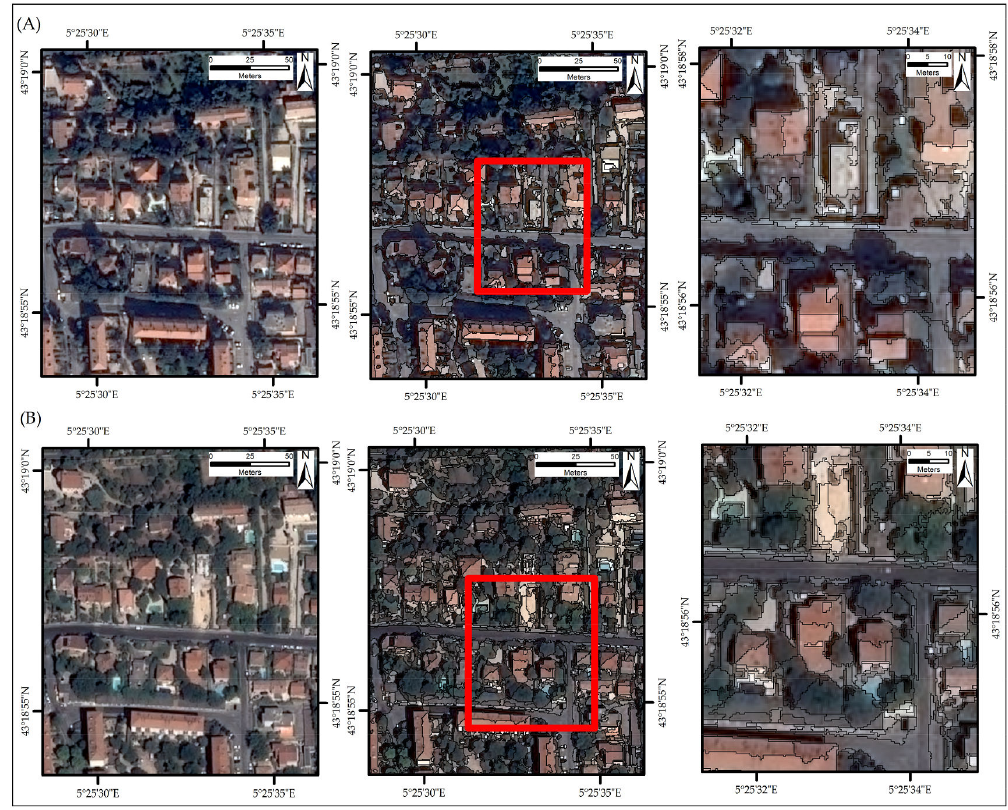
Figure 5. Segmentation results over ( A ) the spring Pl é iades image and ( B ) the summer Pl é iades image. Right images show a higher level of details for which the extent is displayed by the red